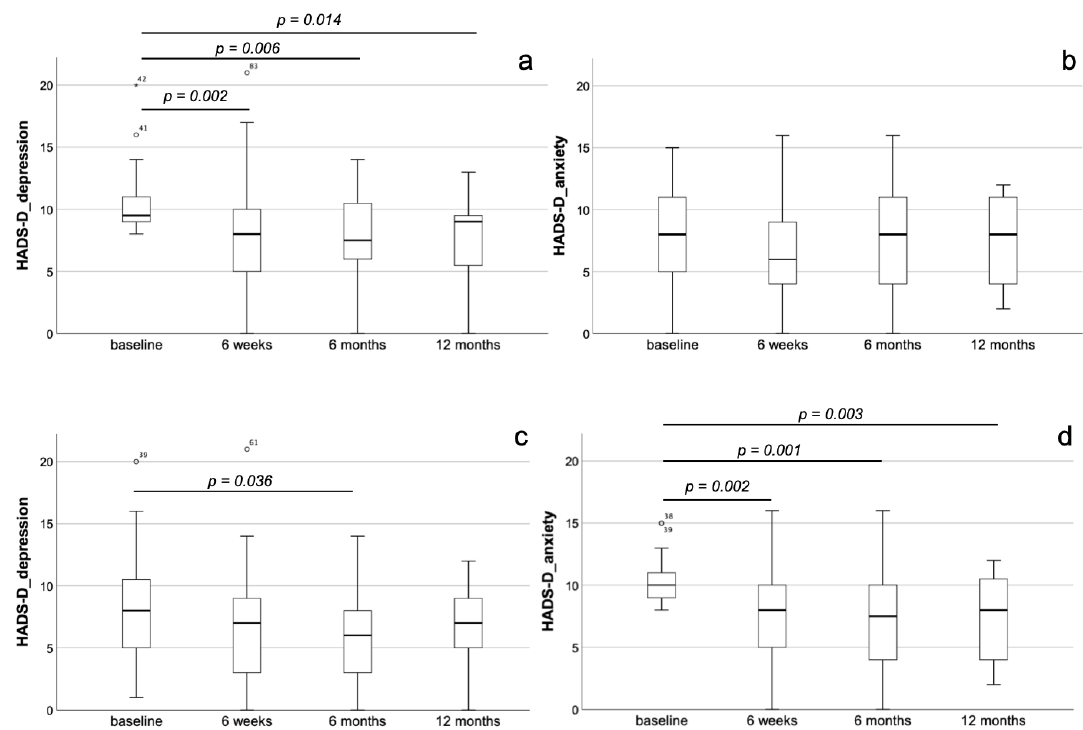
Figure 3. Dynamics of depression and anxiety after TAVI in staging group A. Development of depression ( a , c ) and anxiety ( b , d ) in the depressive ( a , b ) and the anxious ( c , d ) subgroup of staging group A. In the depressive subgroup, there was a significant and persisting decrease of depression at the 6-week, the 6-month as well as the 12-month follow-up, each compared to baseline ( a ). In contrast, in these patients, no dynamics with respect to anxiety could be observed ( b ). In the anxious subgroup, we could also detect a significant and stable decrease of anxiety at the 6-week, the 6-month and at the 12-month follow-up, each compared with baseline ( c ). When considering depression in these patients, we could not evidence any dynamics over time ( d